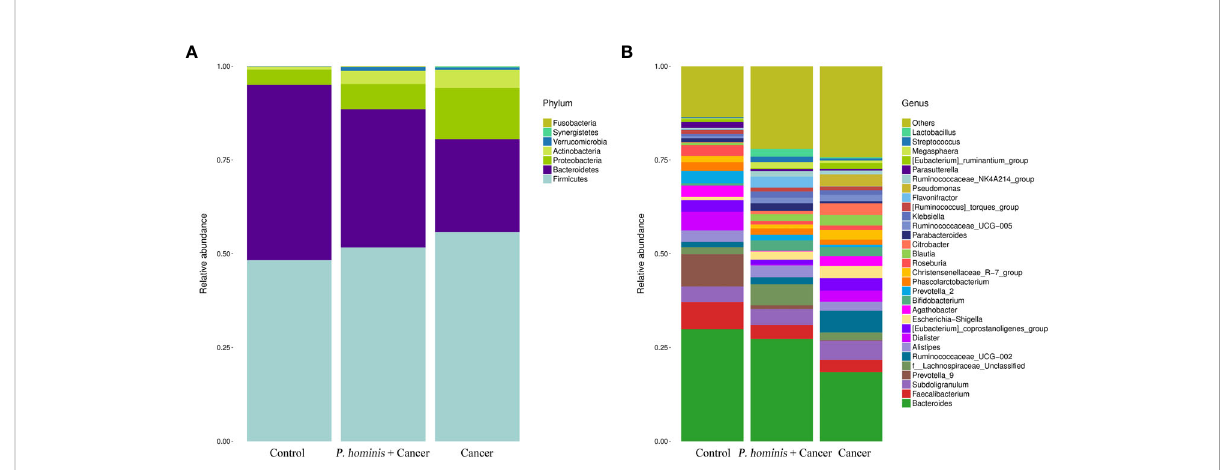
FIGURE 2 Comparison of gut microbiota at phylum and genus levels. (A) Relative abundance of the top 7 phyla in the fecal samples of the Control, Cancer, and P. hominis+ cancer groups. (B) Relative abundance of the top 30 genera in the fecal samples of the Control, Cancer, and P. hominis + cancer groups.